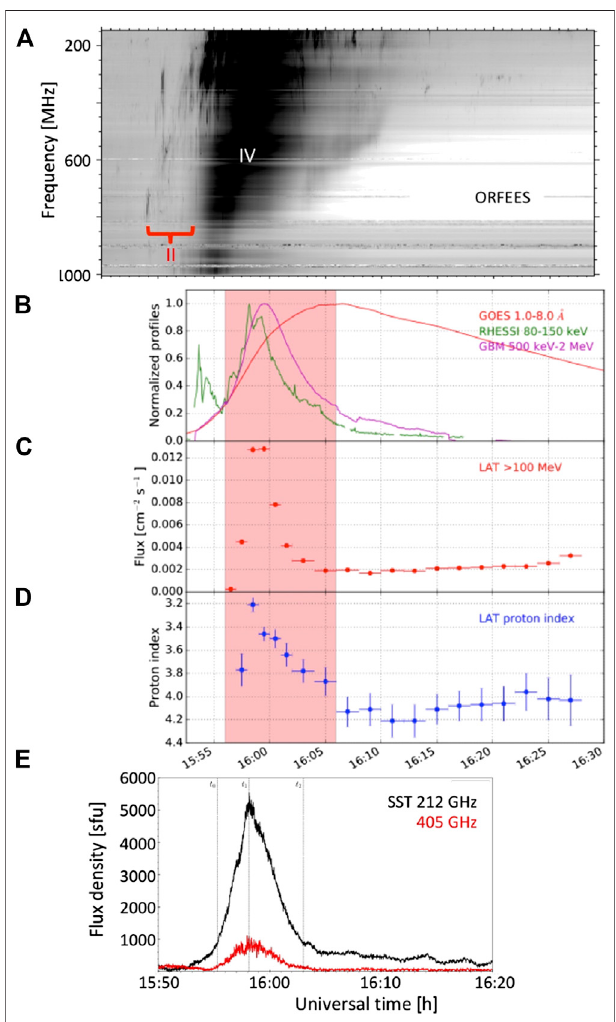
FIGURE 5 | Time history of pion-decay gamma-ray and hard X-ray emission (panels b – d, from Omodei et al., 2018. ©AAS; reproduced with permission) compared with the millimetric and sub-millimetric radio burst observed by the Submillimeter Solar Telescope (SST; courtesy G. Gimenez de Castro, Univ. MacKenzie Sao Paulo; panel e) and the dynamic spectrum in the 140 – 1,000 MHz range (ORFEES spectrograph, Nançay, France; panel a). The ORFEES observations are affected by offpointing due to sunset after about 16 UT. Type II and IV bursts are